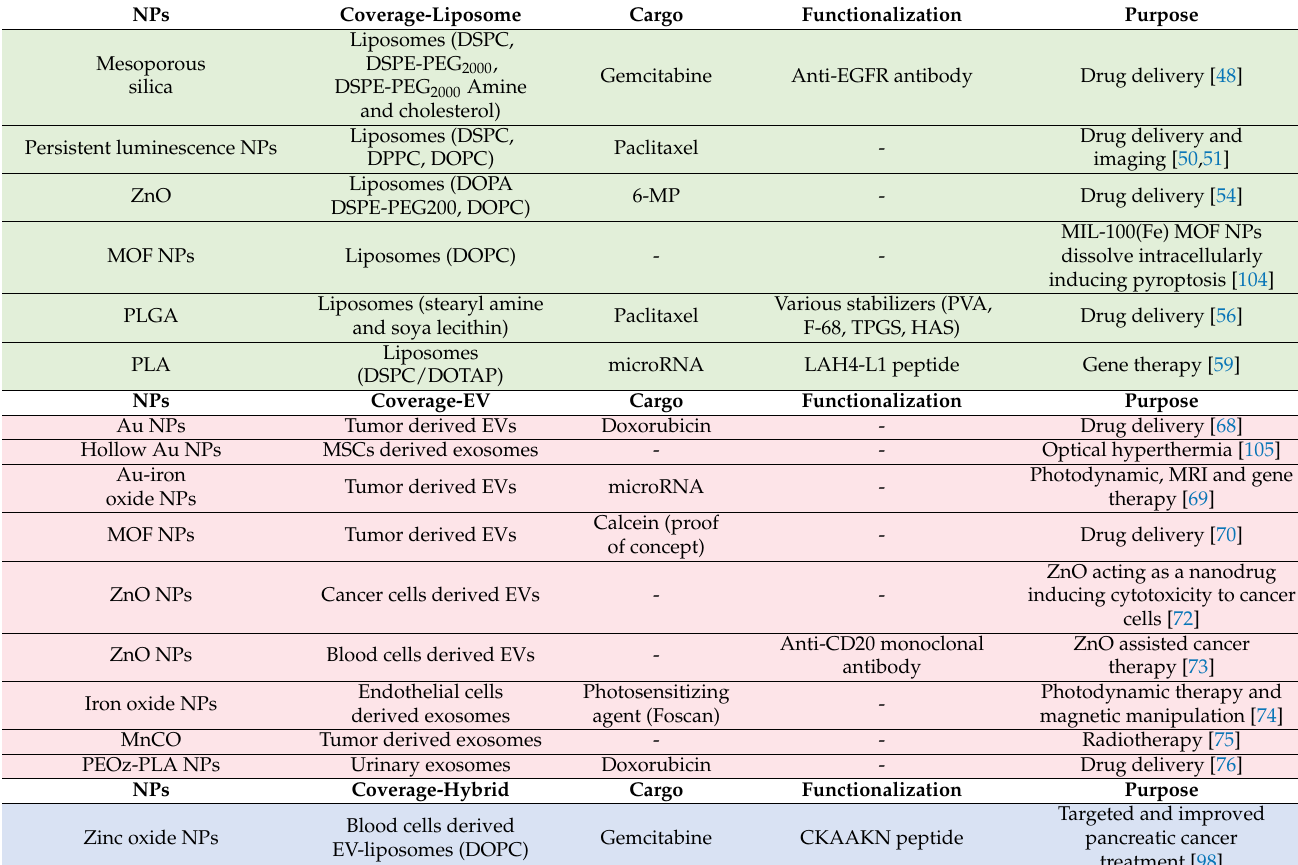
Table 1. In vitro studies on solid-state nanoparticles enclosed in lipidic-based shell, extracellular vesicles or engineered hybrid vesicles. Green background color refers to artificial liposomes, pink refers to extracellular vesicles and blue to engineered, hybrid and artificial extracellular